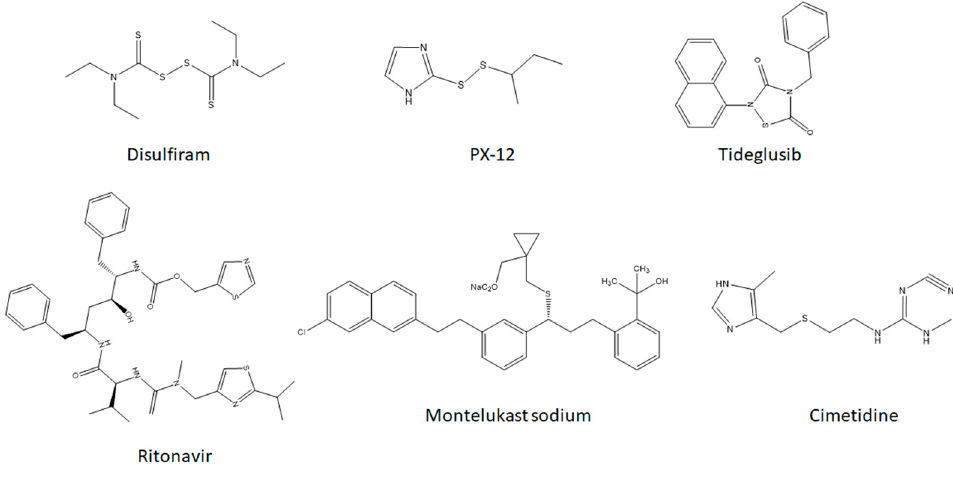
Figure 1. The structures of the compounds with known binding affinity.